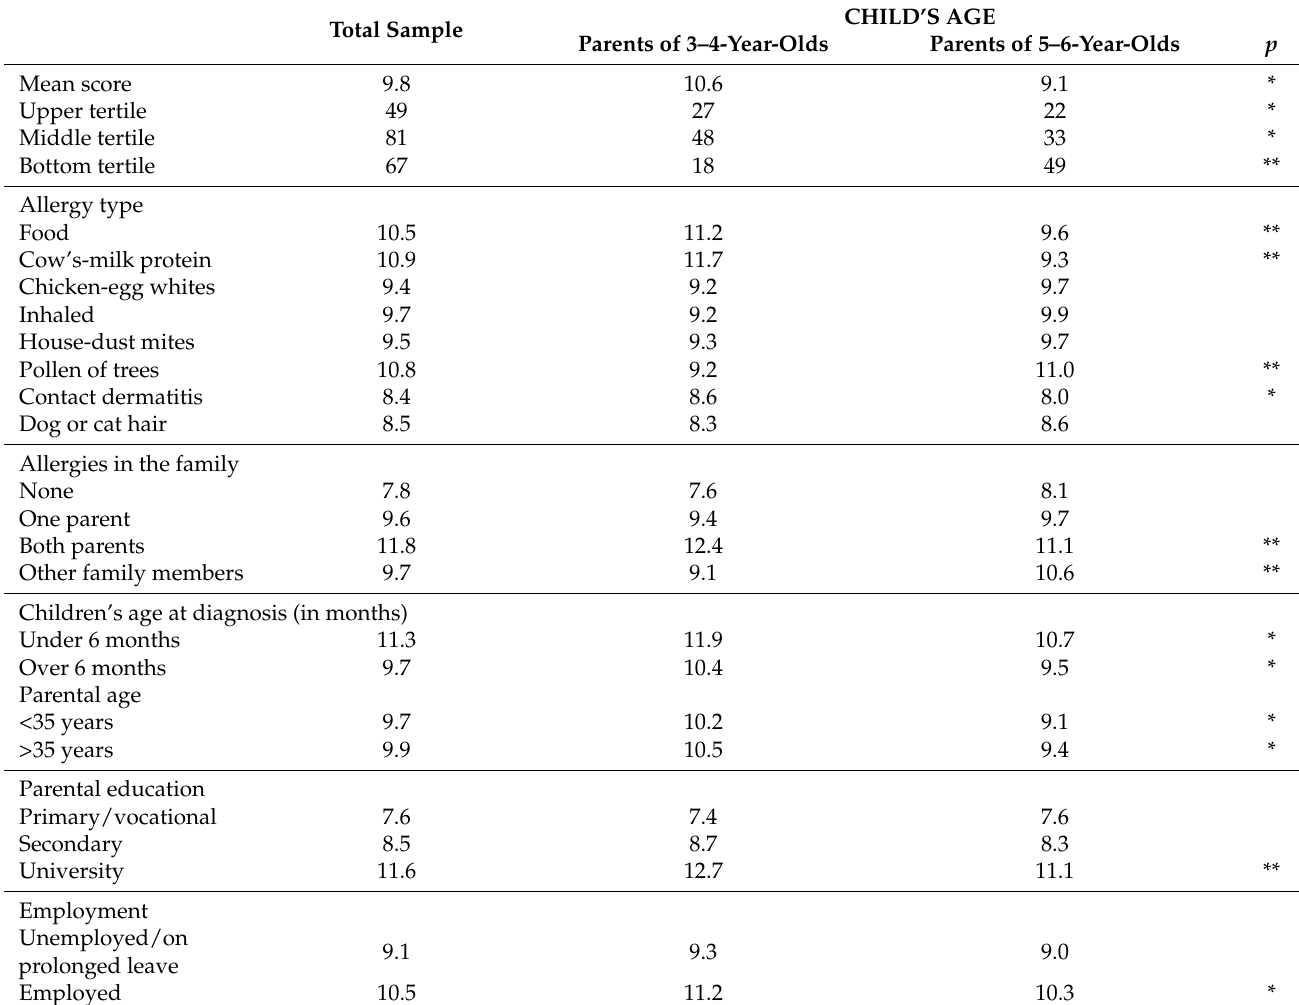
Table 3. Allergy-knowledge score (in points) and factors that influence parental knowledge about